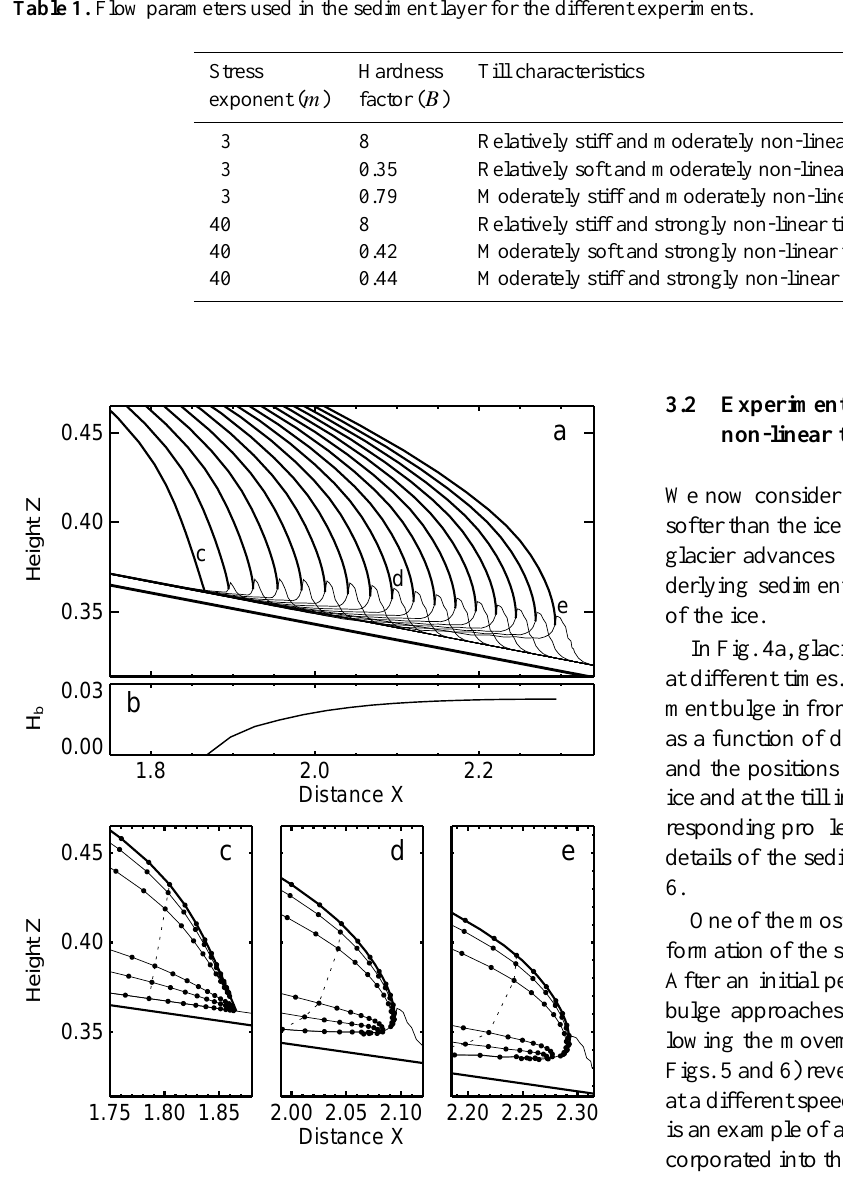
Fig. 4. Experiment B: Relatively soft and moderately non-linear till ( m =3 , B =0 . 35 ): (a) several glacier surfaces are shown at approximately two dimensionless time unit intervals. Selected front positions and surface shapes marked (c) , (d) and (e) are shown in more detail in subfigures (c–e). (b) shows the maximum height H b of the sediment bulge as a function of its horizontal position. Note how, after the initial build up phase, the bulge reaches a constant thickness. (c–e) snapshots of the front showing the surface, four selected internal layers and the ice-sediment interface at dimensionless times T equal to 0 (c), 16 (d) and 32 (e). The dots indicate material particles and can be followed throughout the three pictures. The connecting lines illustrate how material layers (fine solid and dashed lines) with initial shape as in (c) become deformed with time.